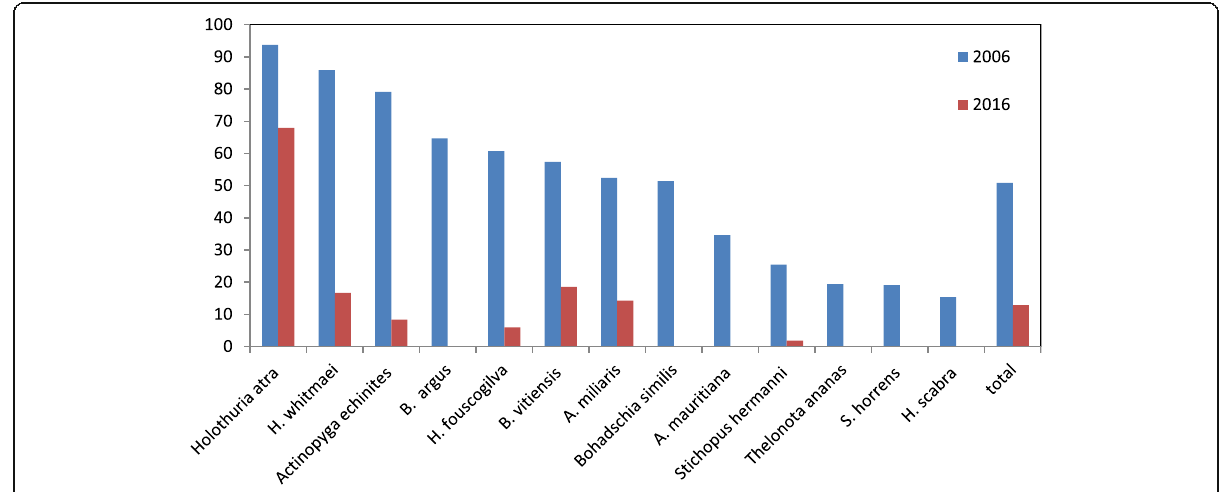
Fig. 2 The percentage of sea cucumber biomass remaining in 2006 and 2016 from the original populations in 2000